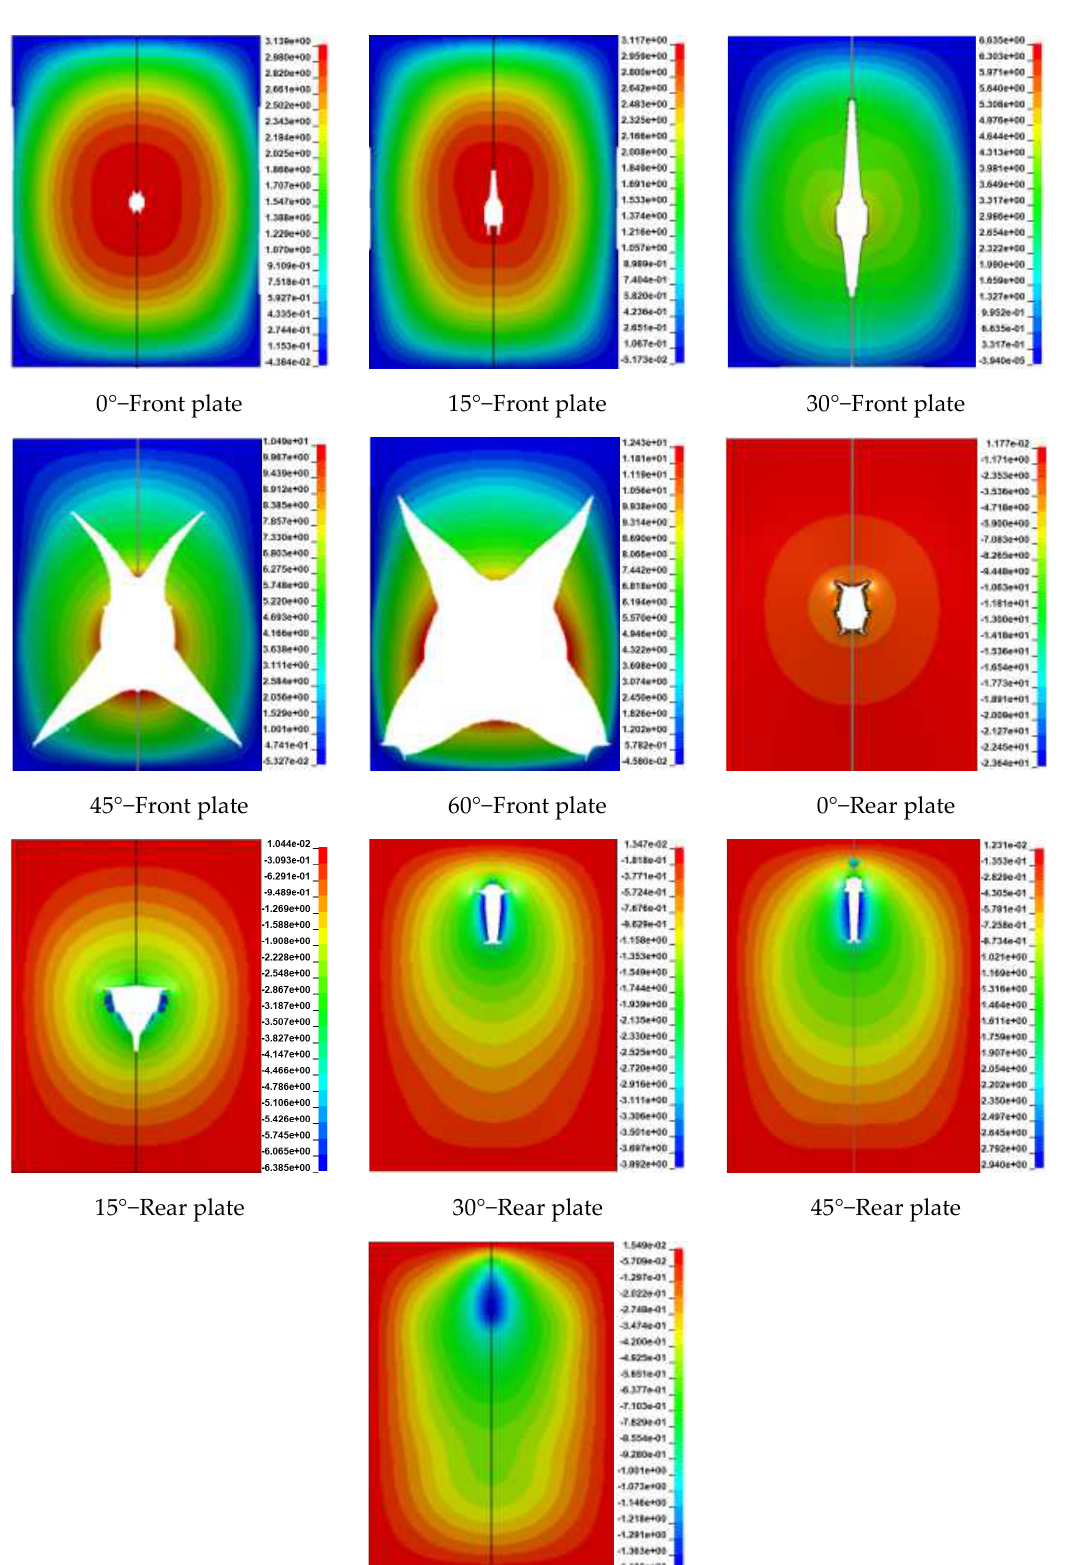
Figure 19. Failure morphology of the front and rear plates at different attack angles (deflection unit: